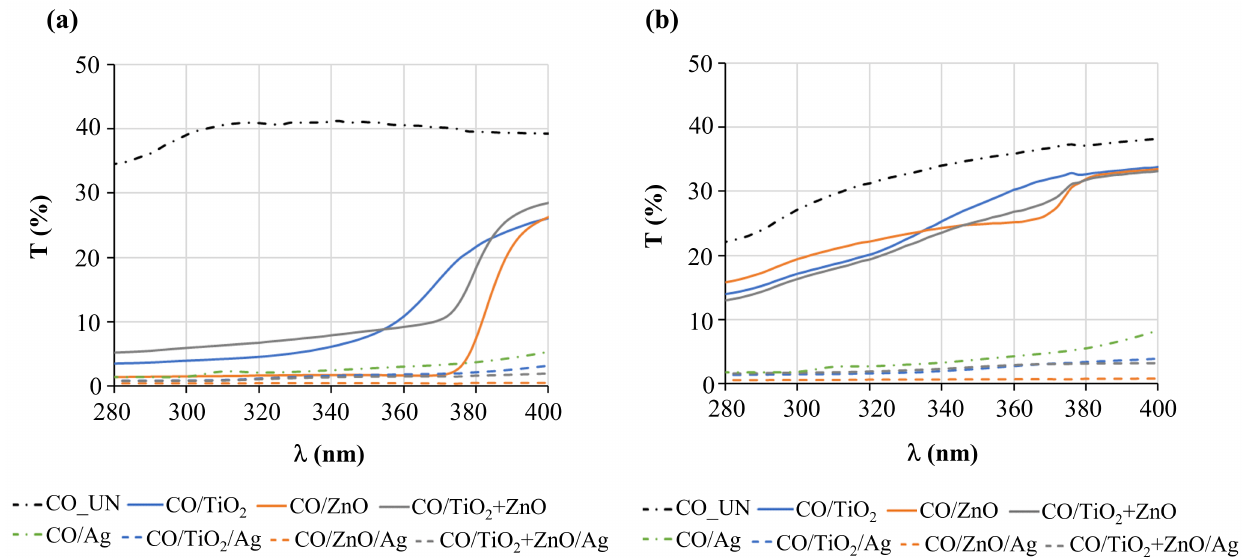
Figure 7. UV transmission spectra of untreated and chemically modified cotton samples before ( a ) and after 25 washings ( b